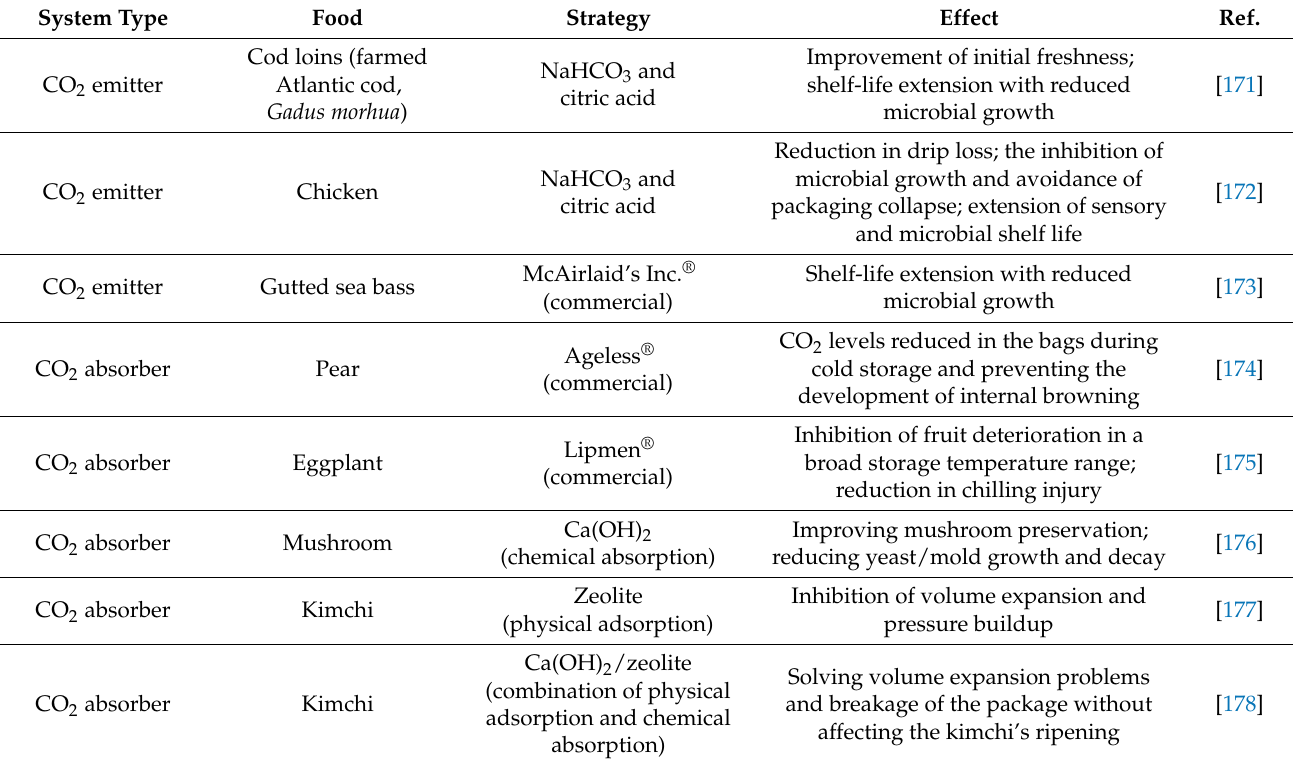
Table 4. Applications of CO 2 emitters and absorbers in active food